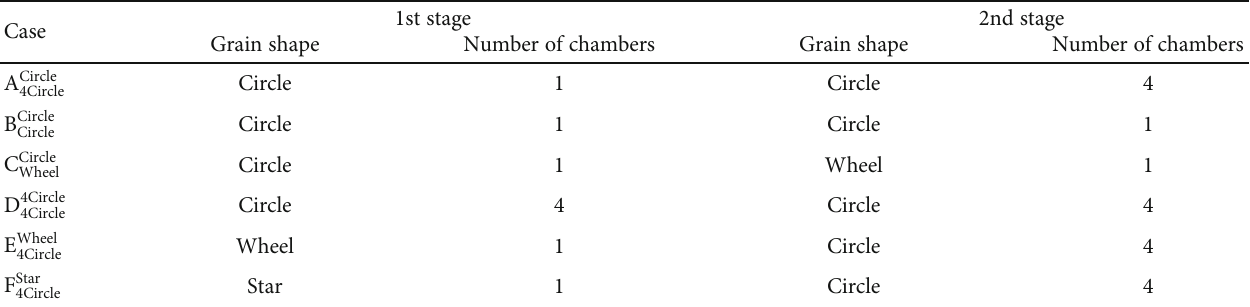
Table 5: SLV cases with di ff erent grain shapes and numbers of